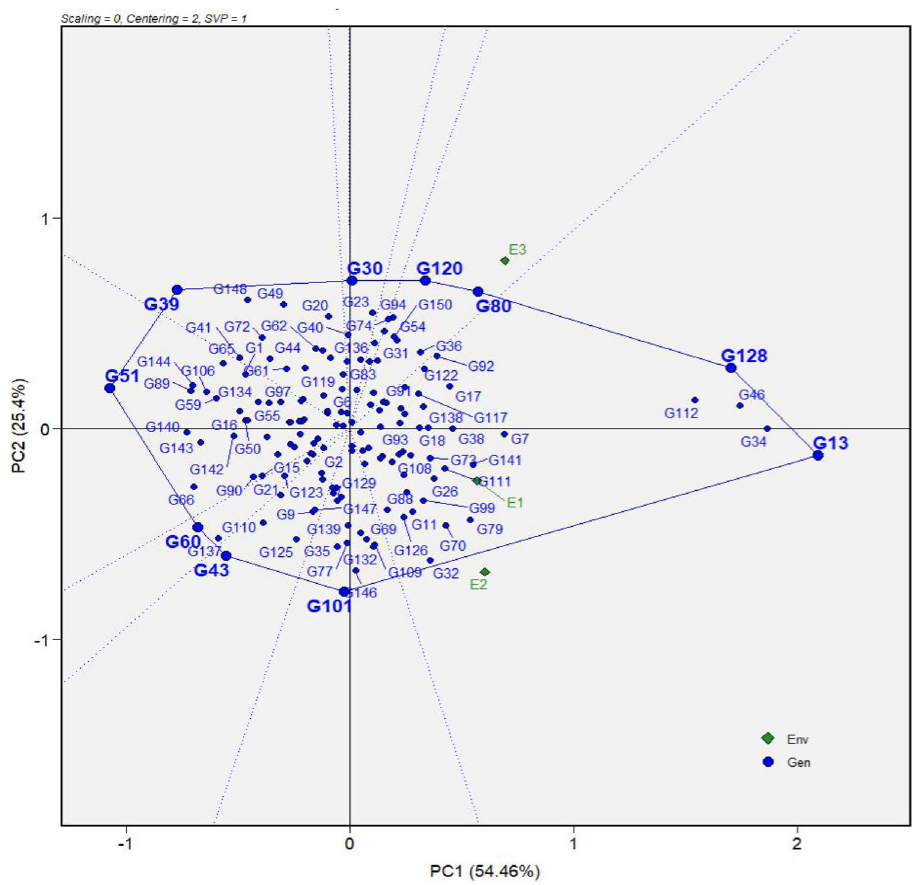
Figure 2. The polygon (which-won-where) view of the genotype main effects plus genotype × environment interaction (GGE) biplot based on the sensory mealiness data of 150 cassava genotypes grown in three environments in Nigeria. Environment names are coded as: E1, Igbariam; E2, Otobi; E3, Umudike. G1-G150 are genotypes defined in Supplementary Table